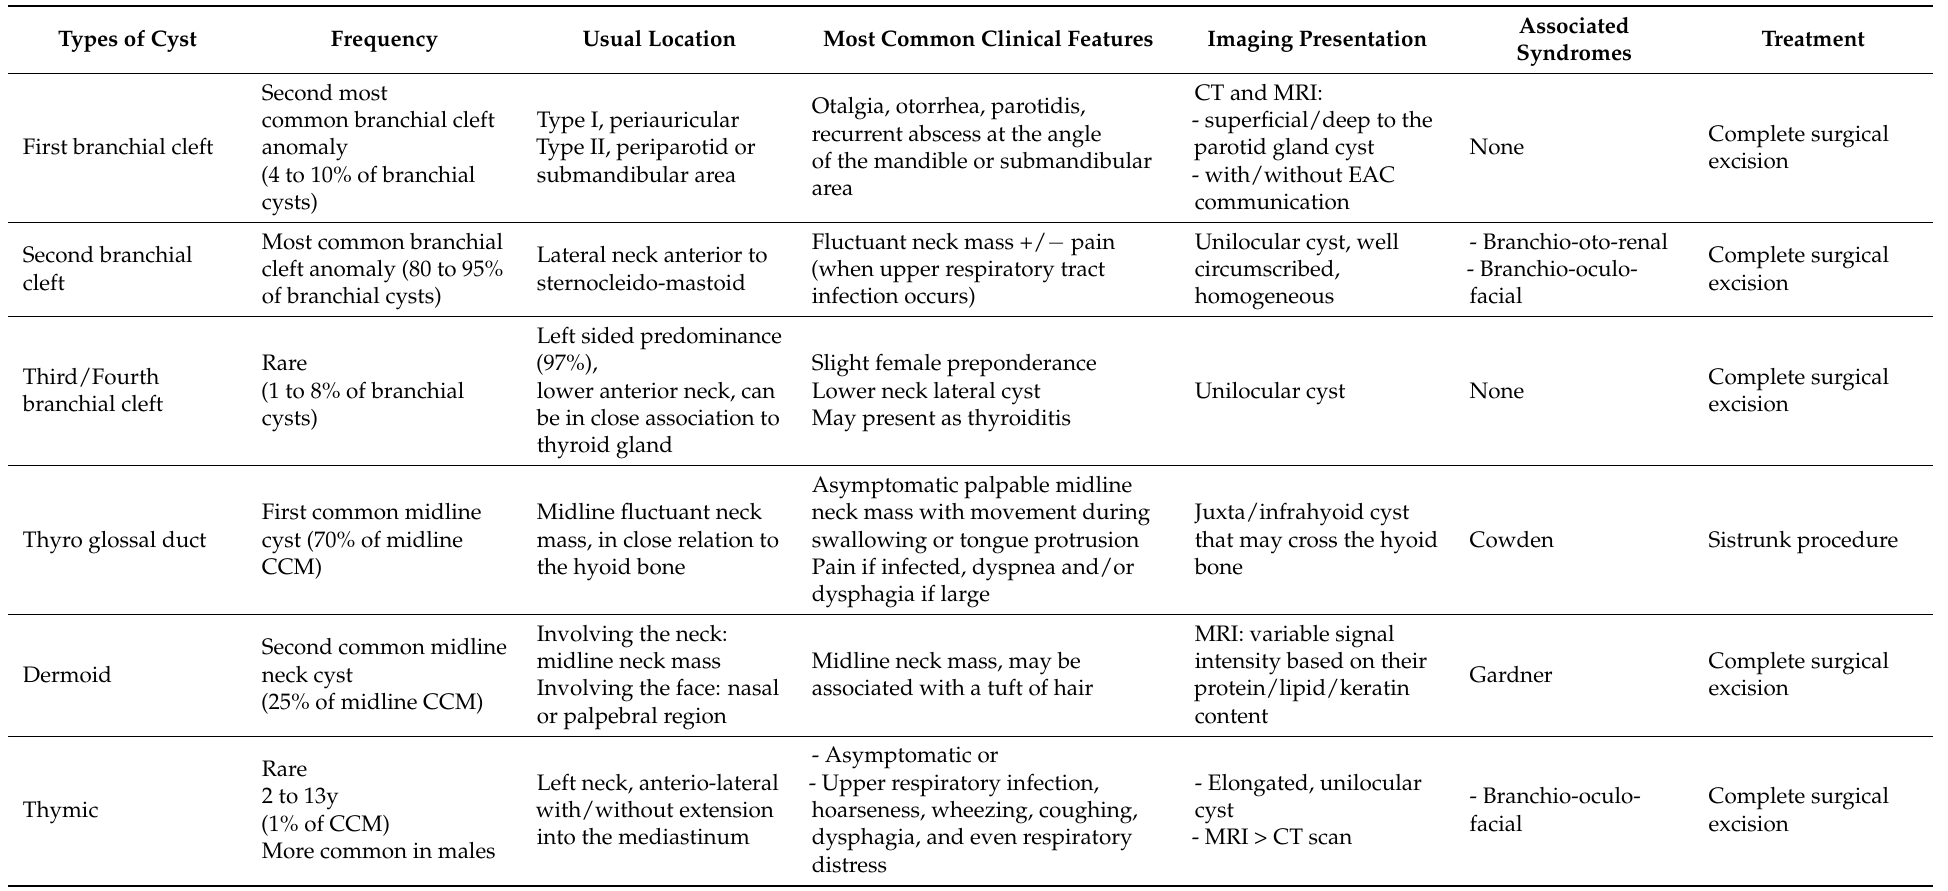
Table 1. Congenital cystic masses (CCM) of the neck: frequency, location, clinical and radiologic presentation, associated syndromes and